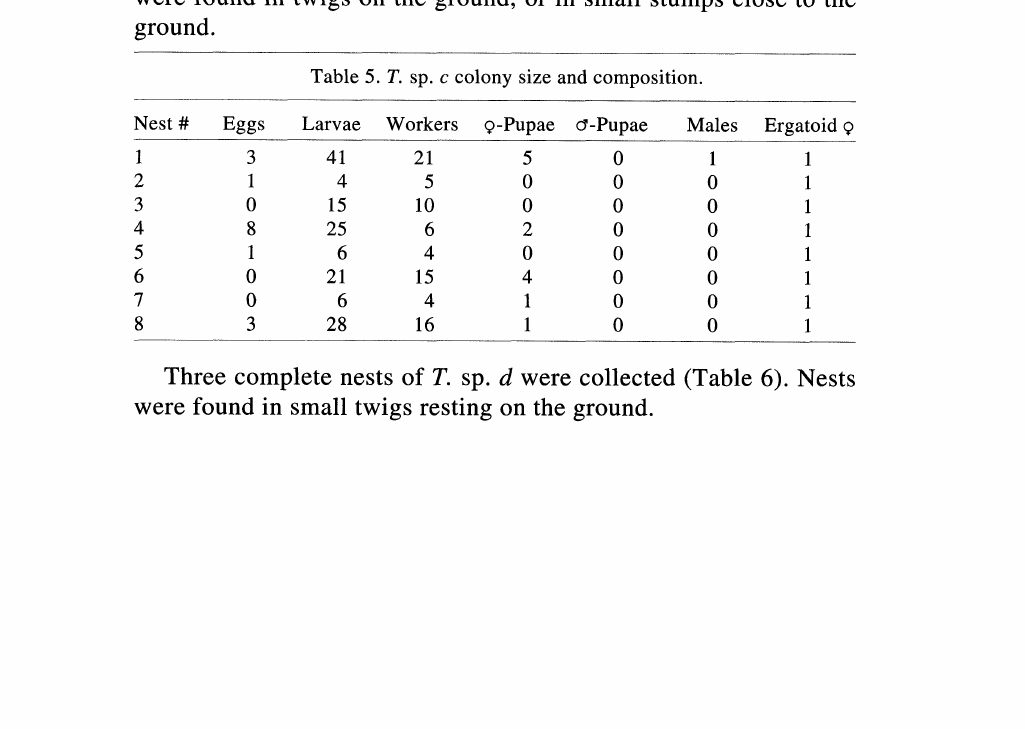
Table 5. T. sp. c colony size and